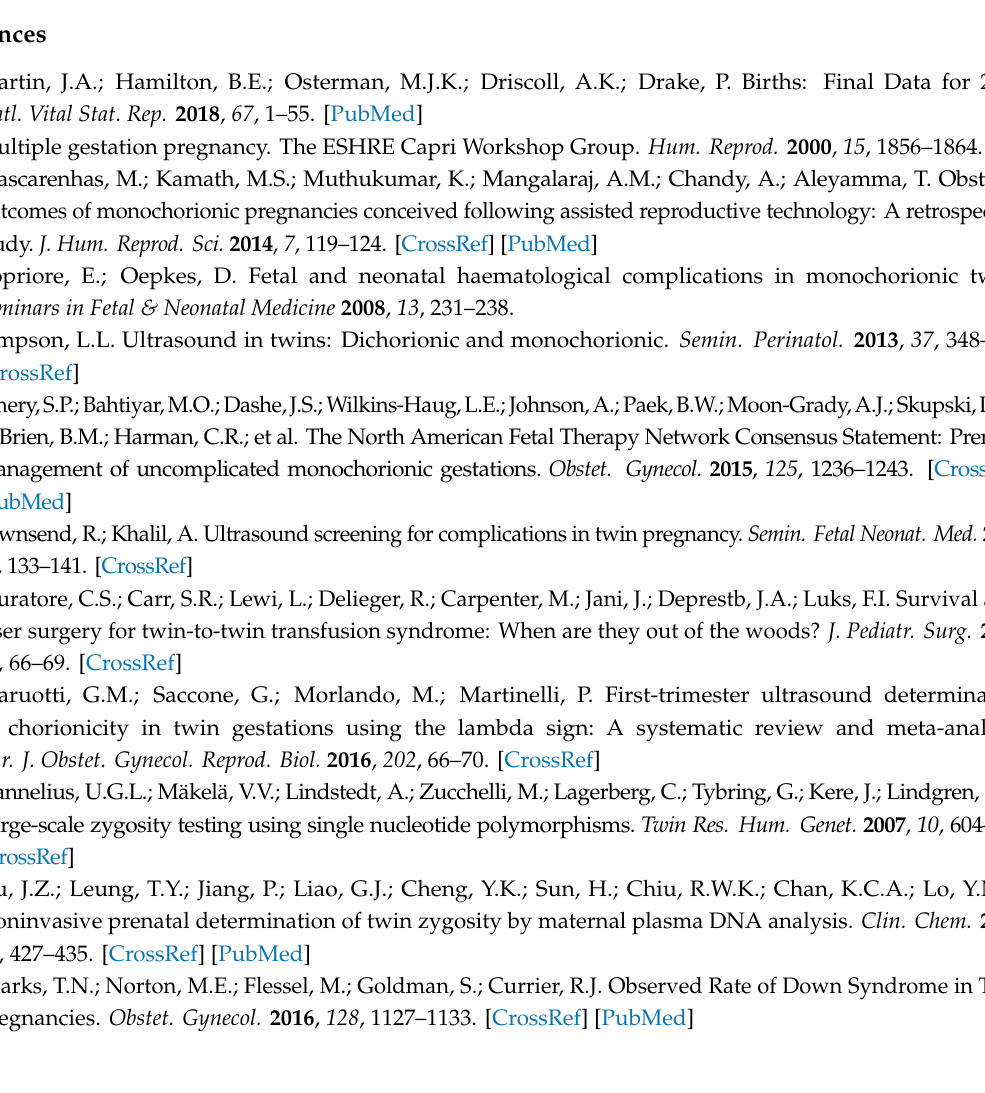
Supplementary Table S1: Numbers of Cases from Each of the Participating Referral Centers; Supplementary Table S2: Patient Demographics; Supplementary Figure S1: Venn Diagram of Twin Cases